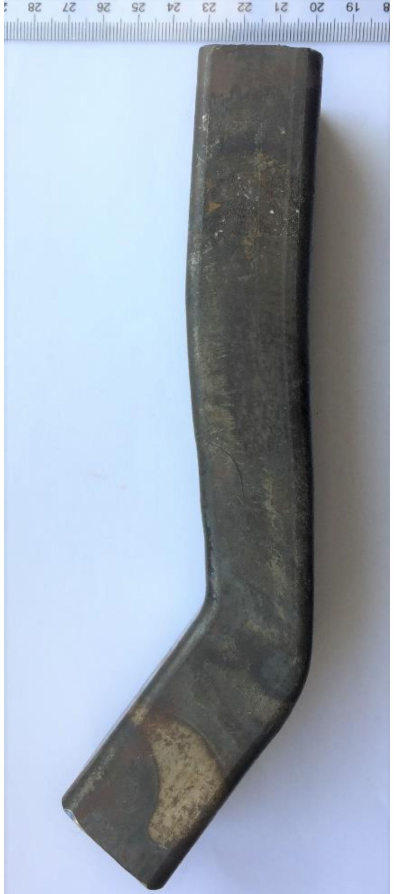
Figure 20. The bent tube under a higher push speed of the bending